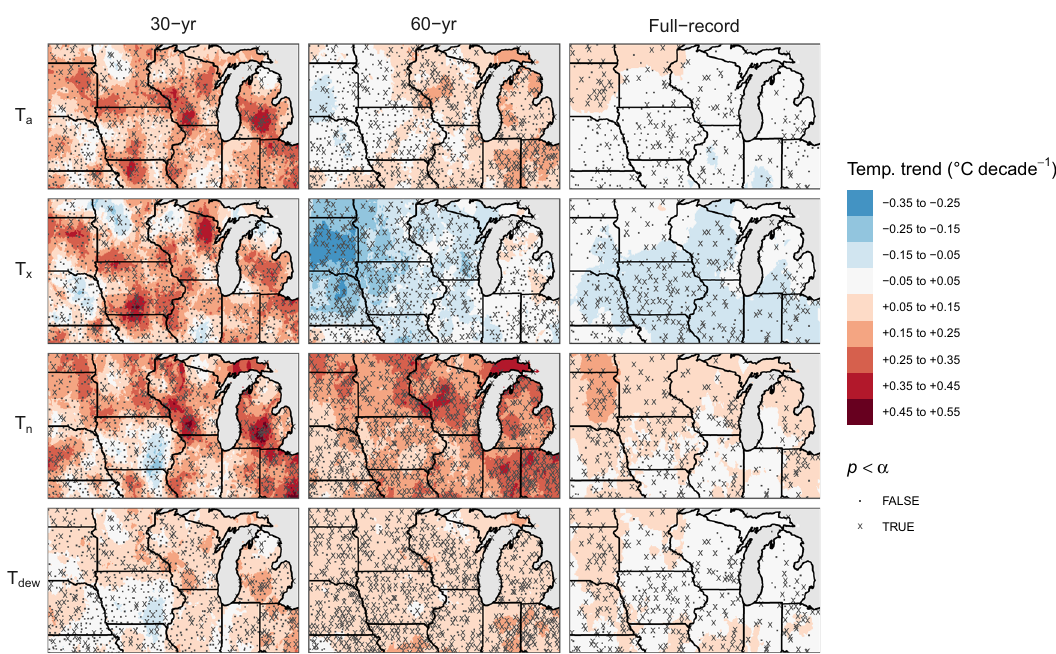
Fig. 2 Spatial patterns of local trends in mean summer daily average ( T a ), maximum ( T x ), minimum ( T n ), and dew point ( T dew ) temperatures for the three time series. Stations marked with a cross ( x ) indicate signi fi cant local trends at the α = 0.1